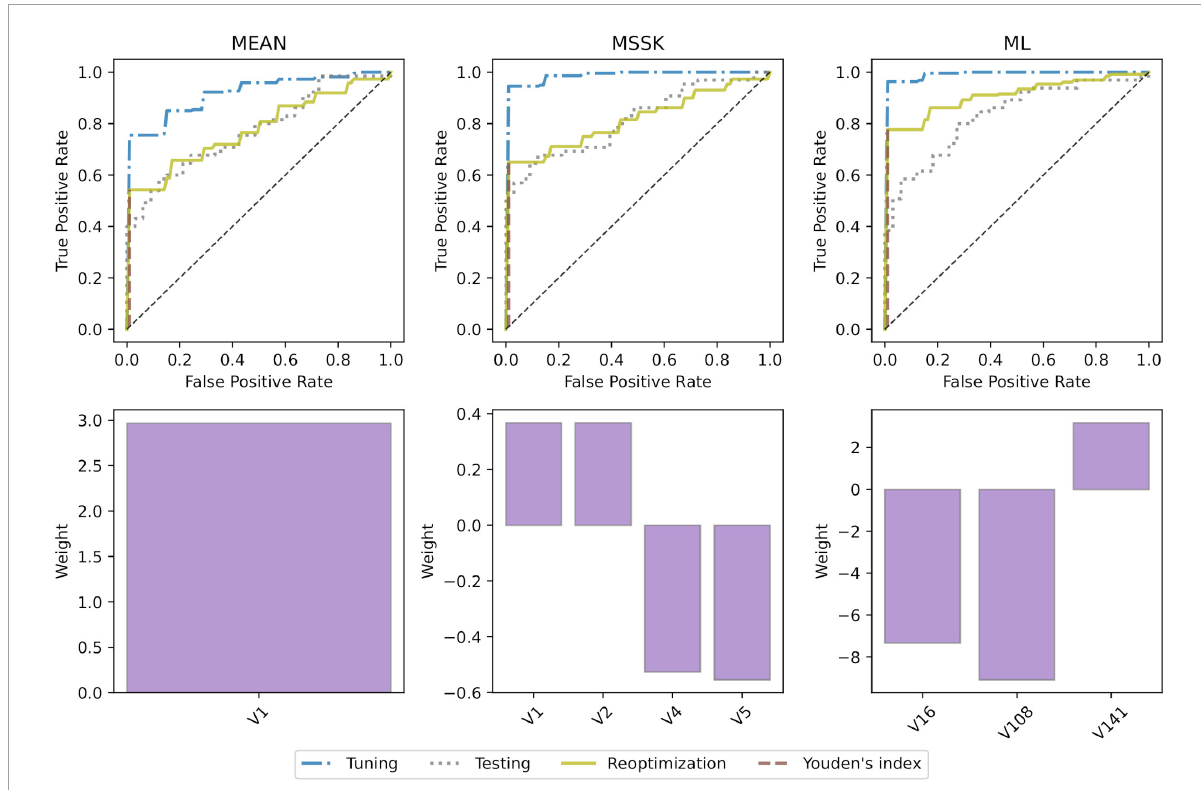
FIGURE5 Model performance and underlying radiomic features. ROC curves and bar plots of the underlying features. V1 - mean (histogram), V2 - standard deviation (histogram), V4 - skewness (histogram), V5 - kurtosis (histogram), V16 - root mean square (histogram), V108 - gray level non-uniformity normalized (GLSZM), V141 - dependence count non-uniformity